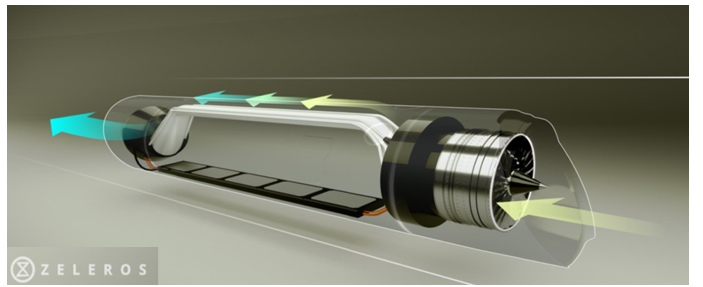
Figure 1. Conceptual model of the complete pod with a frontal compressor.